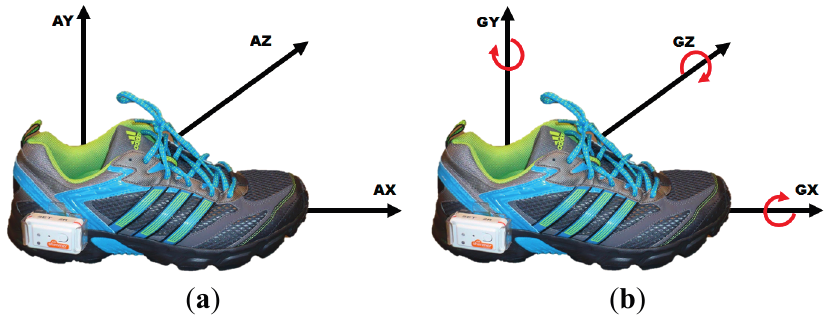
Figure 1. Shimmer sensor unit mounted with custom designed clip on the lateral side of a regular sport shoe. The directions of the sensor axes are shown accordingly to the sensor placement on the shoe. ( a ) Accelerometer; ( b )